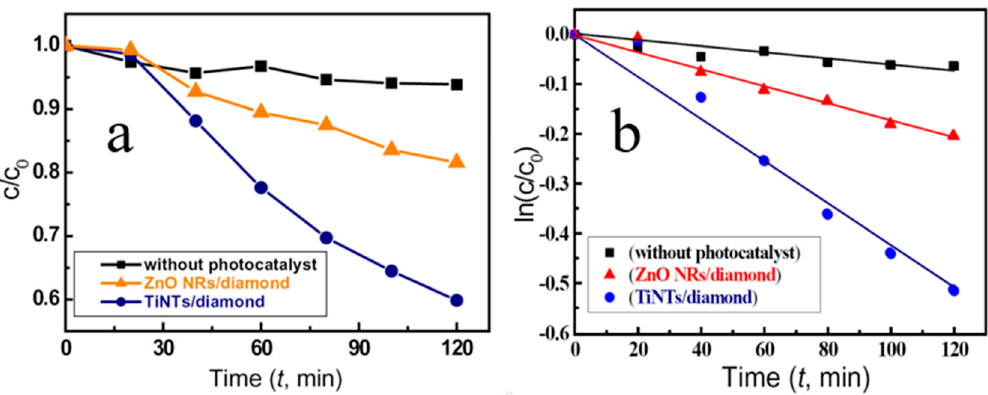
Figure 18. Photocatalytic decomposition of RY15 solution with ( a ) TiO 2 NTs on hemispherical diamond film (TiO 2 NTs/diamond). ( b ) The linear relationship between ln(C/C 0 ) and time [104].